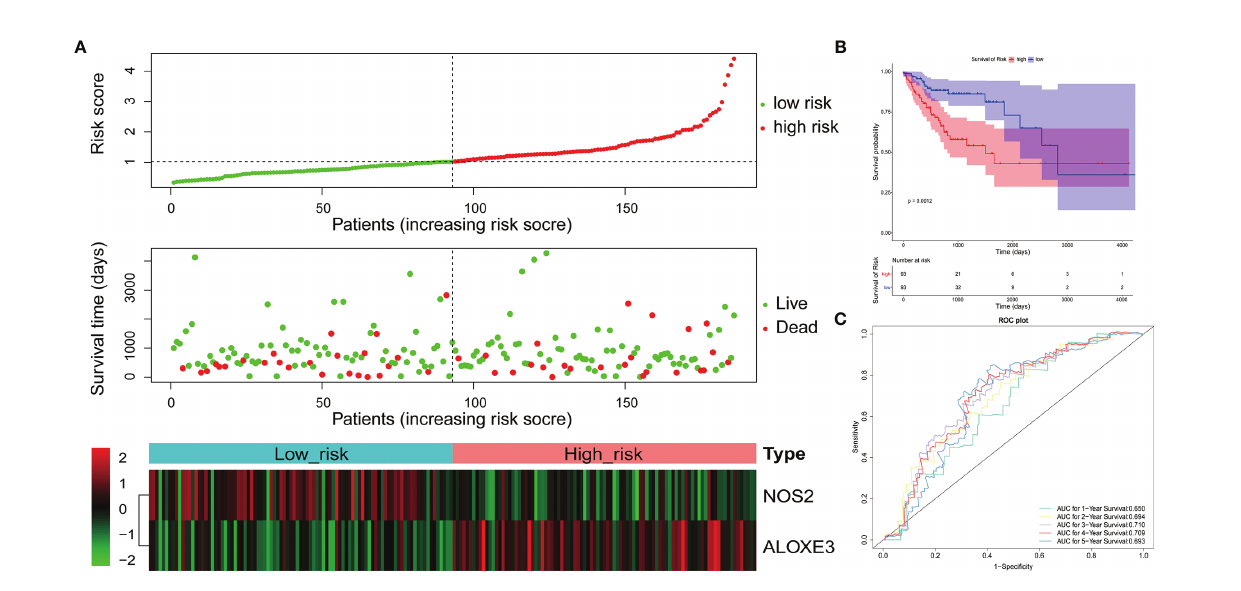
FIGURE 5 | Validation of the 2-gene signature in the whole TCGA-RCRC cohort. (A) Distribution of the risk score, the associated survival data, and the mRNA expression heat map in the whole TCGA-RCRC cohort. (B) Kaplan-Meier plot for OS based on risk score of the two gene-based signature of patients with RCRC in the whole TCGA-RCRC cohort. (C) AUC of time-dependent ROC curves in the whole TCGA-RCRC